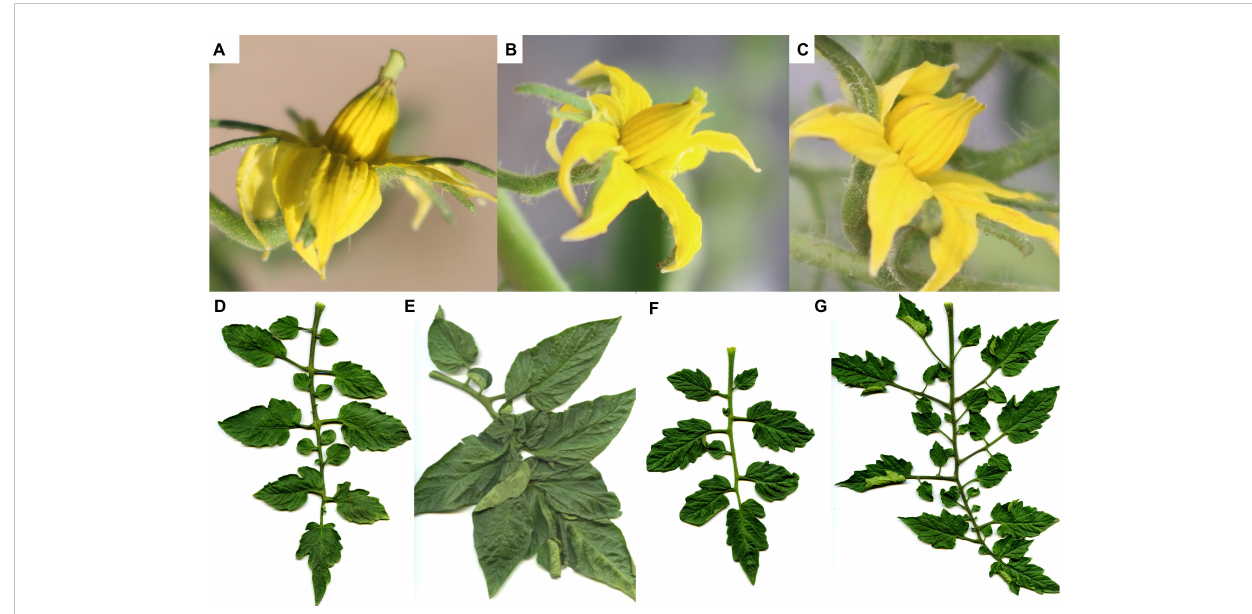
FIGURE 2 Morphological stigma and leaf diversity. Levels of fl ower stigma exertion are shown from A to C (A) SLY159 with a highly exerted stigma (0.4 mm); (B) SLY123 with an exerted stigma (0.1 mm); (C) SLY74 without an exerted stigma ( − 0.8 mm). Leaf morphotypes are shown from D to G (D) SLY66 plant with a normal leaf phenotype (seven lea fl ets); (E) SLY66 plant with a reduced number of lea fl et phenotype ( fi ve lea fl ets); (F) SLY49 plant with a reduced number of secondary lea fl et phenotype; (G) SLY49 plant with a high number of secondary lea fl et